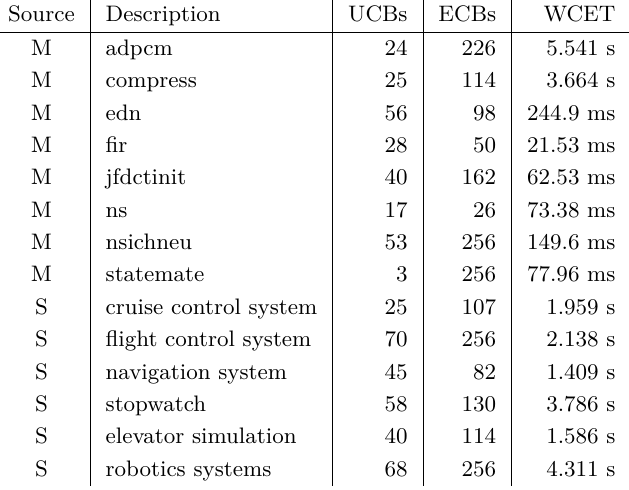
Table 3 Execution times and number of UCBs and ECBs for the largest benchmarks from the Mälardalen Benchmark Suite (M), and SCADE Benchmarks (S). (s = second, ms =